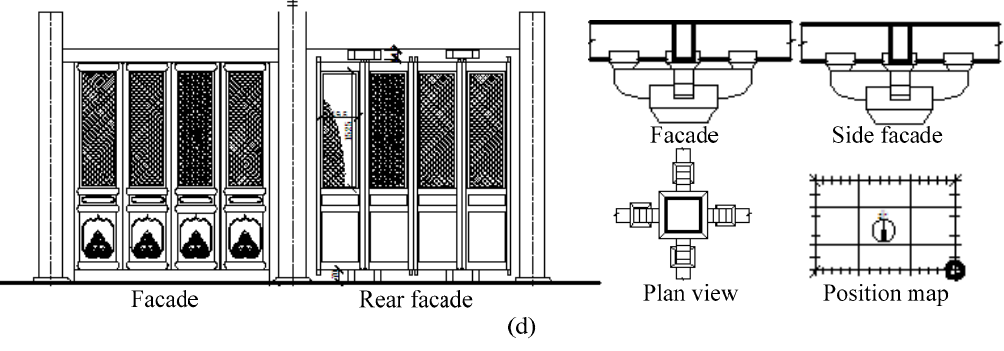
Figure 15. Fine drawings of Liangyi Temple. ( a ) Plane drawings (layout); ( b ) facade drawings; ( c ) section drawings; ( d ) window drawings and bracket set drawings.